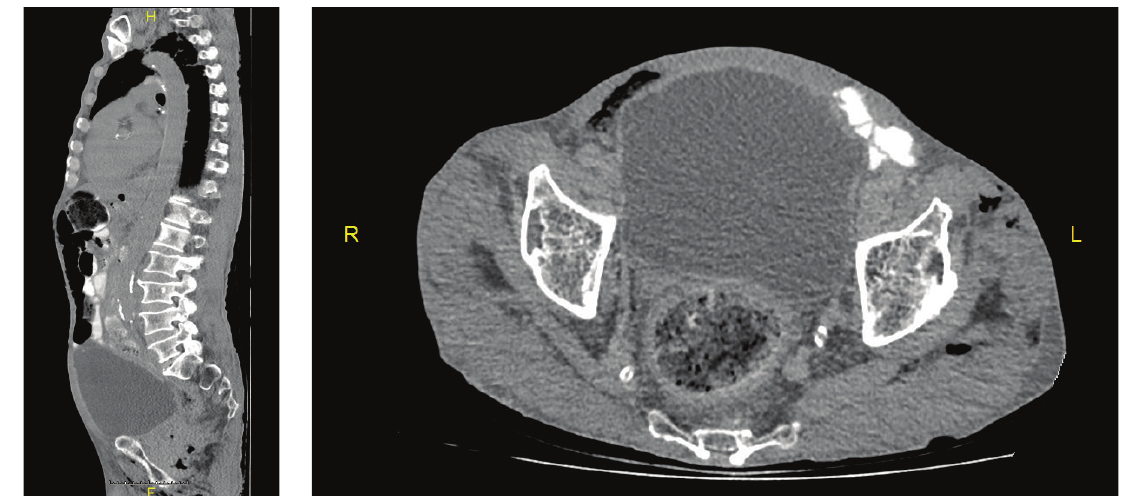
Figure 4: An image of tumor of the prostate.